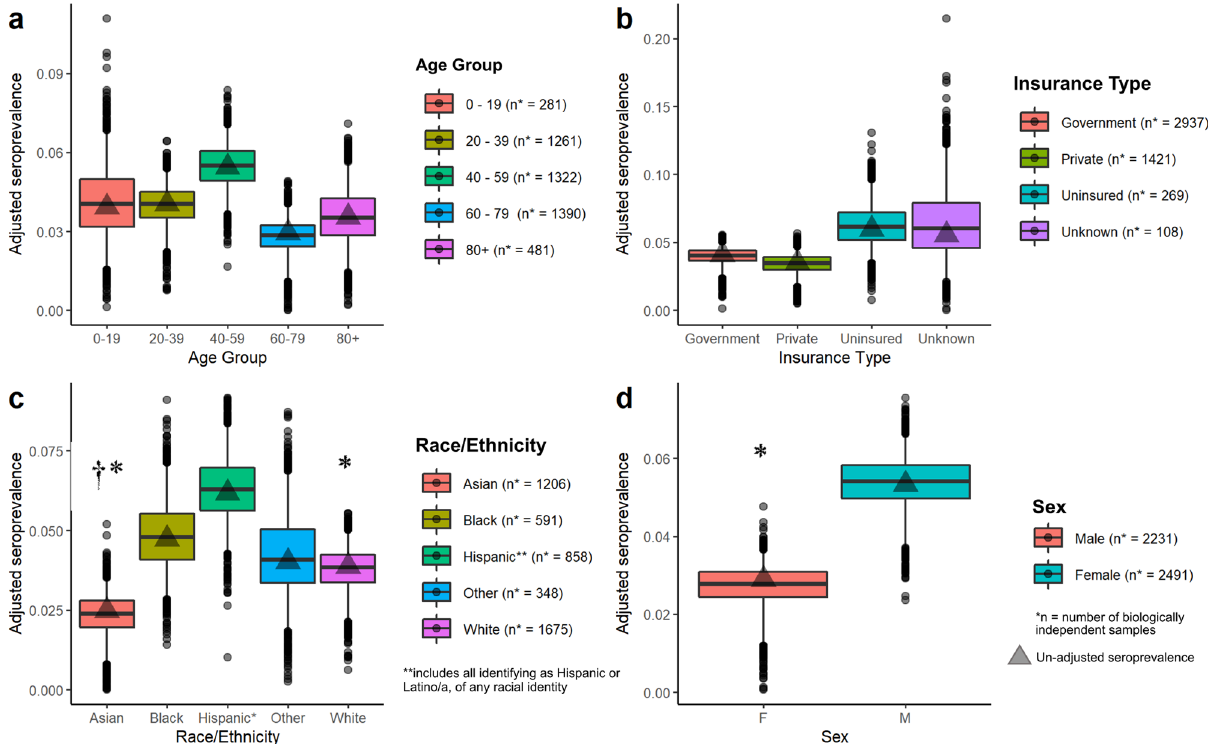
Fig. 3 Strati fi ed seroprevalence by demographic group. Box and whisker plots showing posterior estimates of seroprevalence from n = 7500 iterations of the algorithm to produce adjusted estimates for test performance (Supplementary Methods1), strati fi ed by a age, b insurance type, c race/ethnicity (groups containing n < 50 samples were included in ‘ other ’ ) and d sex. The shaded triangle shows the raw seroprevalence estimate. The number of biologically independent samples used to calculate raw and adjusted seroprevalence estimates for each strati fi ed group are shown in the fi gure legends. The midline of the boxplot shows the median of the posterior, the upper and lower edges of the box show the 25% and 75% quantiles, whiskers show 95% credible interval of the posterior. Points show posterior estimates outside of this interval. For ( c ), stars (*) indicate the race/ethnic groups where the 2.5% and 97.5% quantiles of the differences in posterior estimates for seroprevalence between samples from Hispanic patients and that group did not cross zero. Crosses ( † ) indicate the ethnic groups where the 2.5% and 97.5% quantiles of the differences in posterior estimates for seroprevalence between samples from Black or African American patients and that group did not cross zero. For ( d ) a star (*) indicates that the 2.5% and 97.5% quantiles of the differences in posterior estimates for seroprevalence between Males and Females did not cross